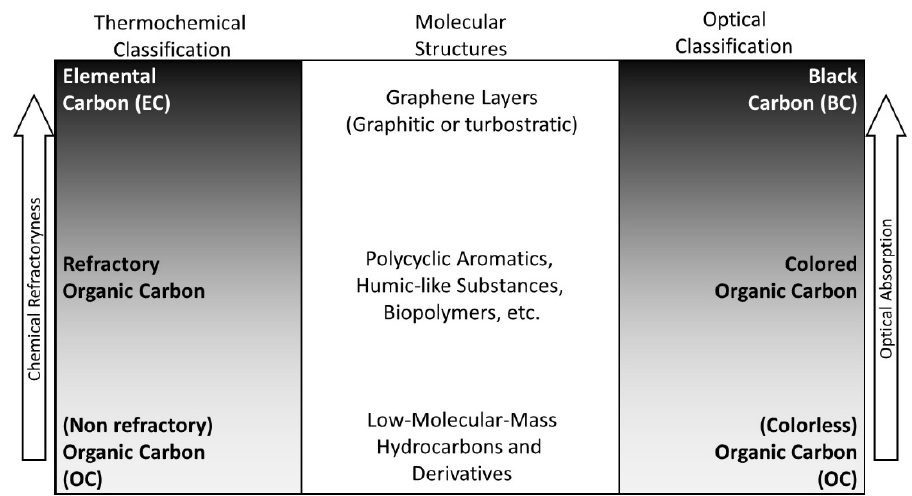
Figure 6. Optical and thermochemical classification of atmospheric carbonaceous particulate matter. BrC is an ensemble of light-absorbing (coloured) organic and relatively refractory macromolecules with a variety of molecular structures (diagram adapted from [72,105]).